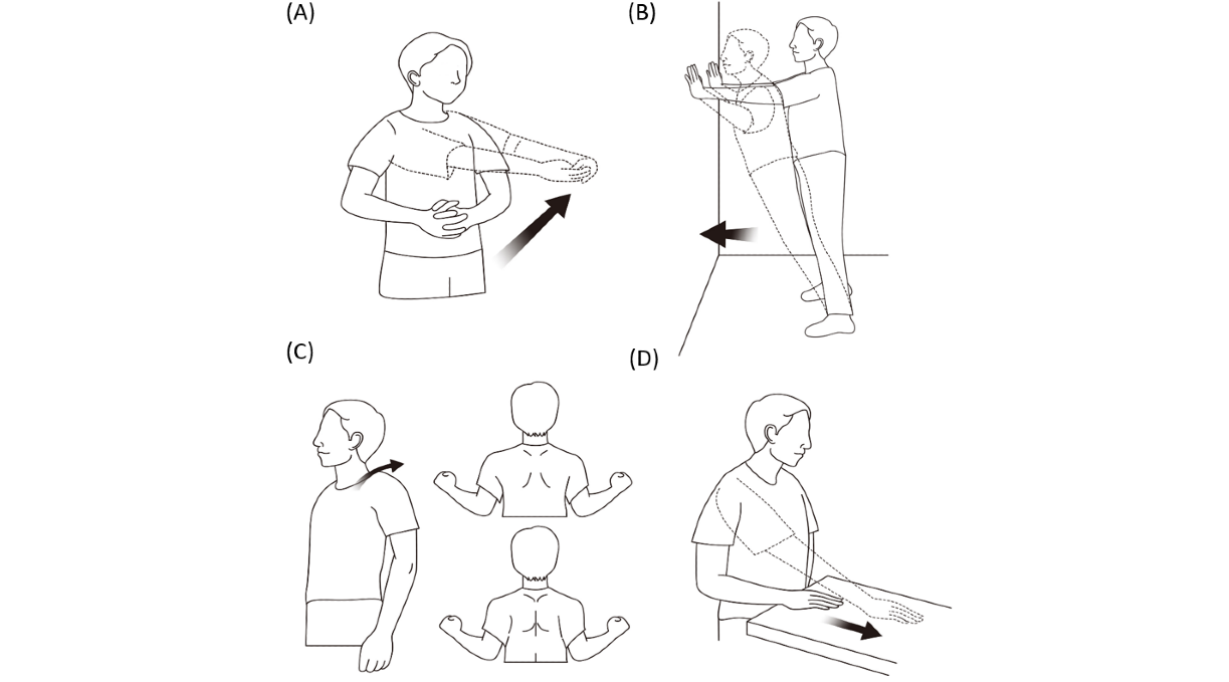
Figure 2. Home rehabilitation exercises for the upper limbs. (A) Bilateral shoulder flexion; (B) Wall push exercise; (C) Active scapular exercise; (D) Towel slide